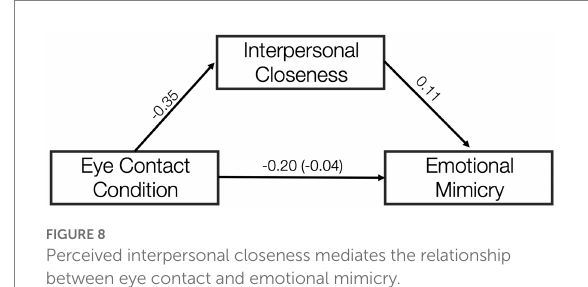
FIGURE 8 Perceived interpersonal closeness mediates the relationship between eye contact and emotional